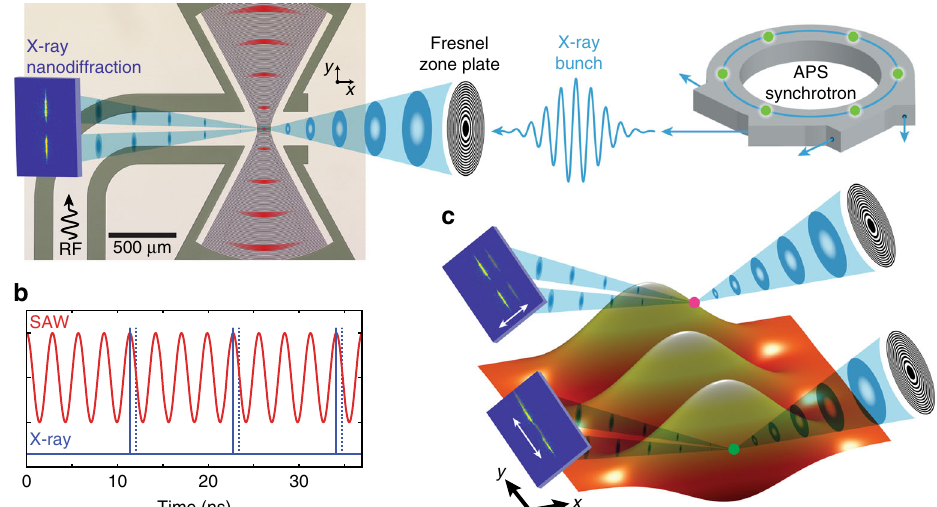
Fig. 1 Sketch of the stroboscopic Scanning X-ray Diffraction Microscopy (s-SXDM) experimental geometry. a Periodic bunch patterns of the Advanced Photon Source (APS) synchrotron are frequency matched to RF continuous wave excitation of a SAW (illustrated in red). Stroboscopic illumination allows for nanoscale SXDM of a virtually frozen wave. b The time domain surface displacement of the SAW (red curve – 1 nm peak-to-peak displacement at 352 MHz) is synchronized to the time structure of the X-ray illumination (blue curve – 22 ps rms width at approximately 88 MHz). This allows a fl exible measurement of the SAW amplitude by varying either time (detuned near-frequency match) or RF phase (at frequency match) to relatively displace the measurement to a new time slice (dotted blue line). c The out-of-plane displacement of the SAW at a fi xed point in time is represented by the orange isosurface, exhibiting both periodic lattice curvature along the wave longitudinal propagation direction y (green dots) and transverse curvature along x (magenta dots) induced by Gaussian focusing of the standing wave. These curvatures induce orthogonal shifts in the far fi eld diffraction pattern that oscillate as a function of the relative phase between the synchrotron time structure and the RF SAW excitation. The two lobe feature of the nanodiffraction patterns is a consequence of the beam stop for the X-ray focusing optic (not